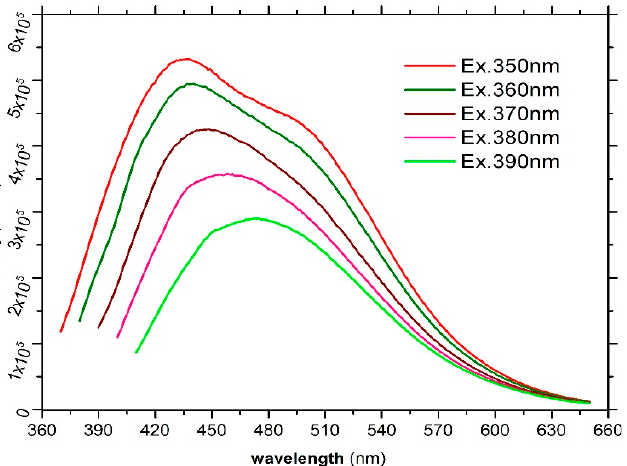
Figure 8. Steady-state PL emission spectra of the prepared CDs recorded within the 350–390 nm excitation range. Table 3. Emission peaks recorded within 350–390 nm excitation.